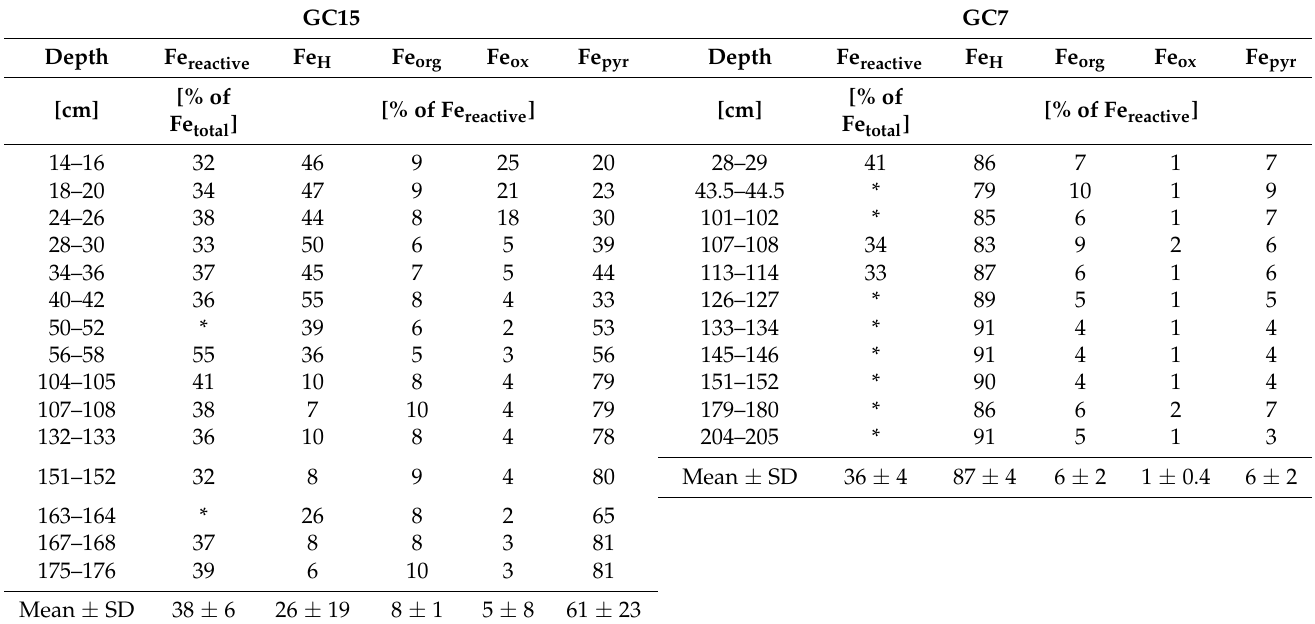
Table A5. Reactive iron speciation (Fe reactive ) for the GC15 and GC7 cores. Fe H (easily extractable fraction with labile ferrous, i.e., FeS and siderite, and ferric iron, i.e., ferrihydrite, akaganeite